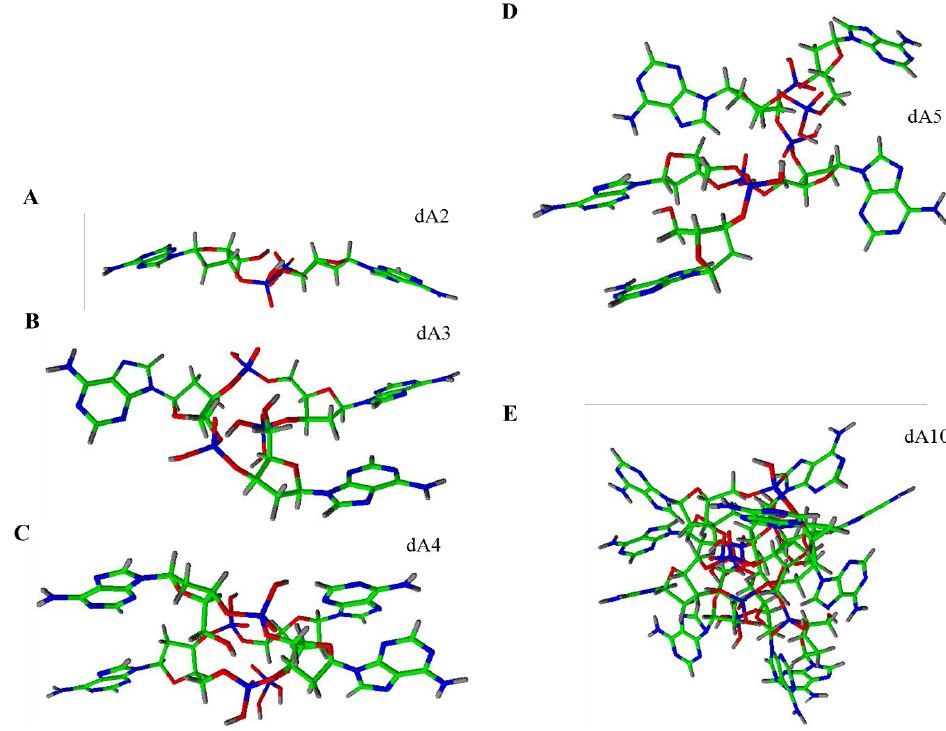
; ( B ) dA ; ( C ) dA ; ( D ) dA 2 3 4 5